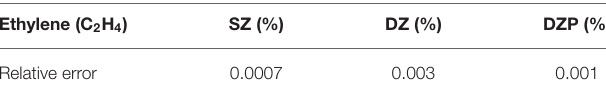
TABLE 1 | The comparison between the results of canonical MP2 and those of Laplace-transformed MP2. H2-line